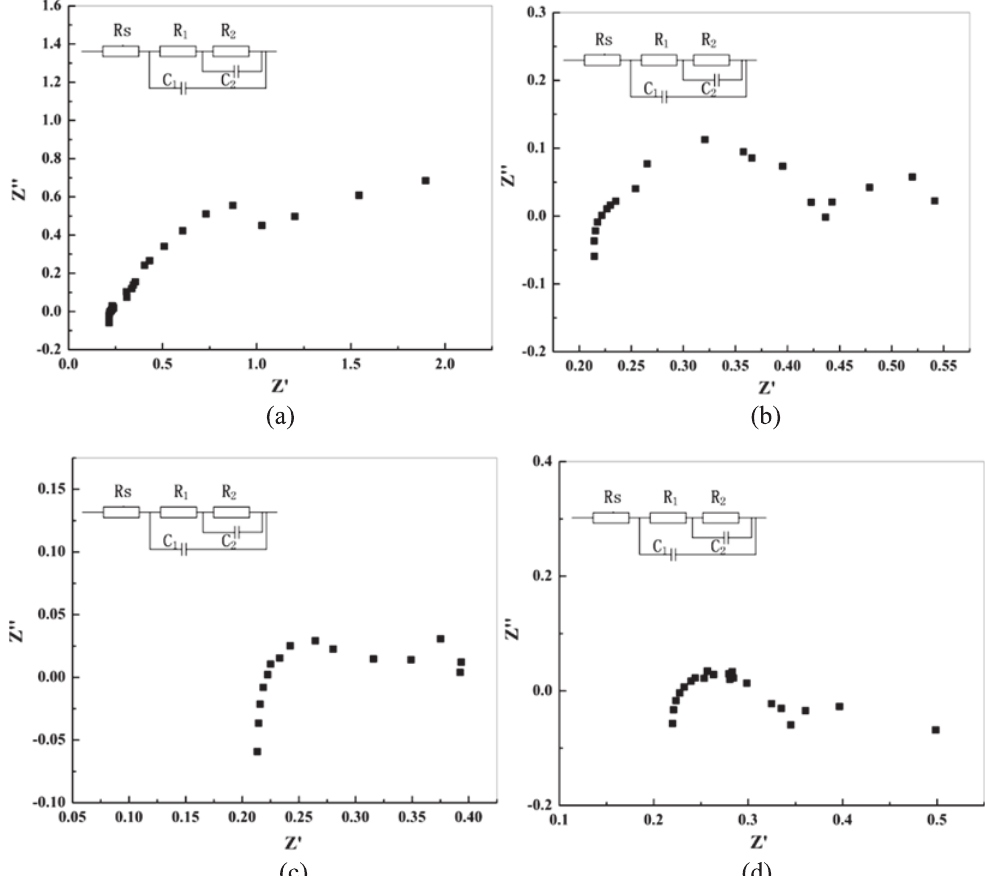
Fig. 3: AC impedance spectra at different potentials. (a) − 0.3 V; (b) − 0.8 V; (c) − 1.3 V; (d) − 1.8